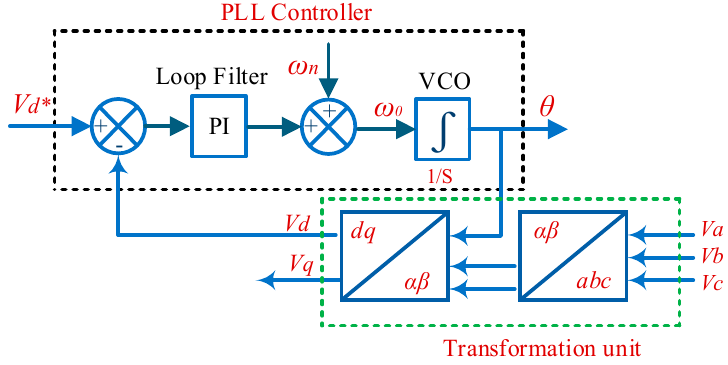
Figure 5. Phase-locked loop synchronous reference frame (SRF-PLL).